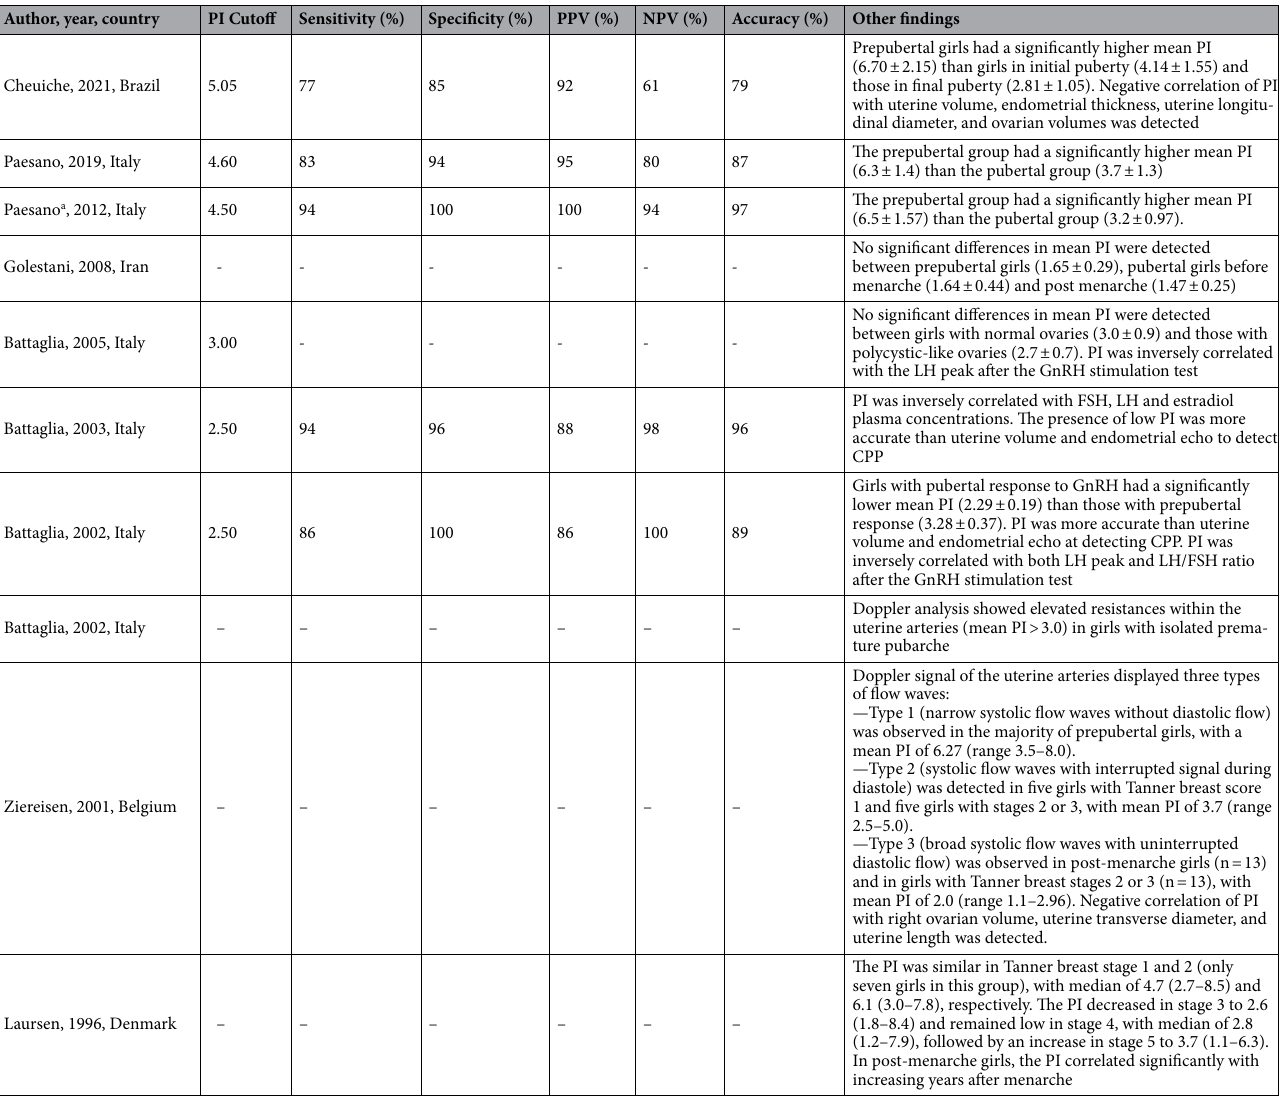
Table 2. Summary of the main results of the diagnostic value of pulsatility index for the diagnosis of pubertal onset. a Published in conference annals.